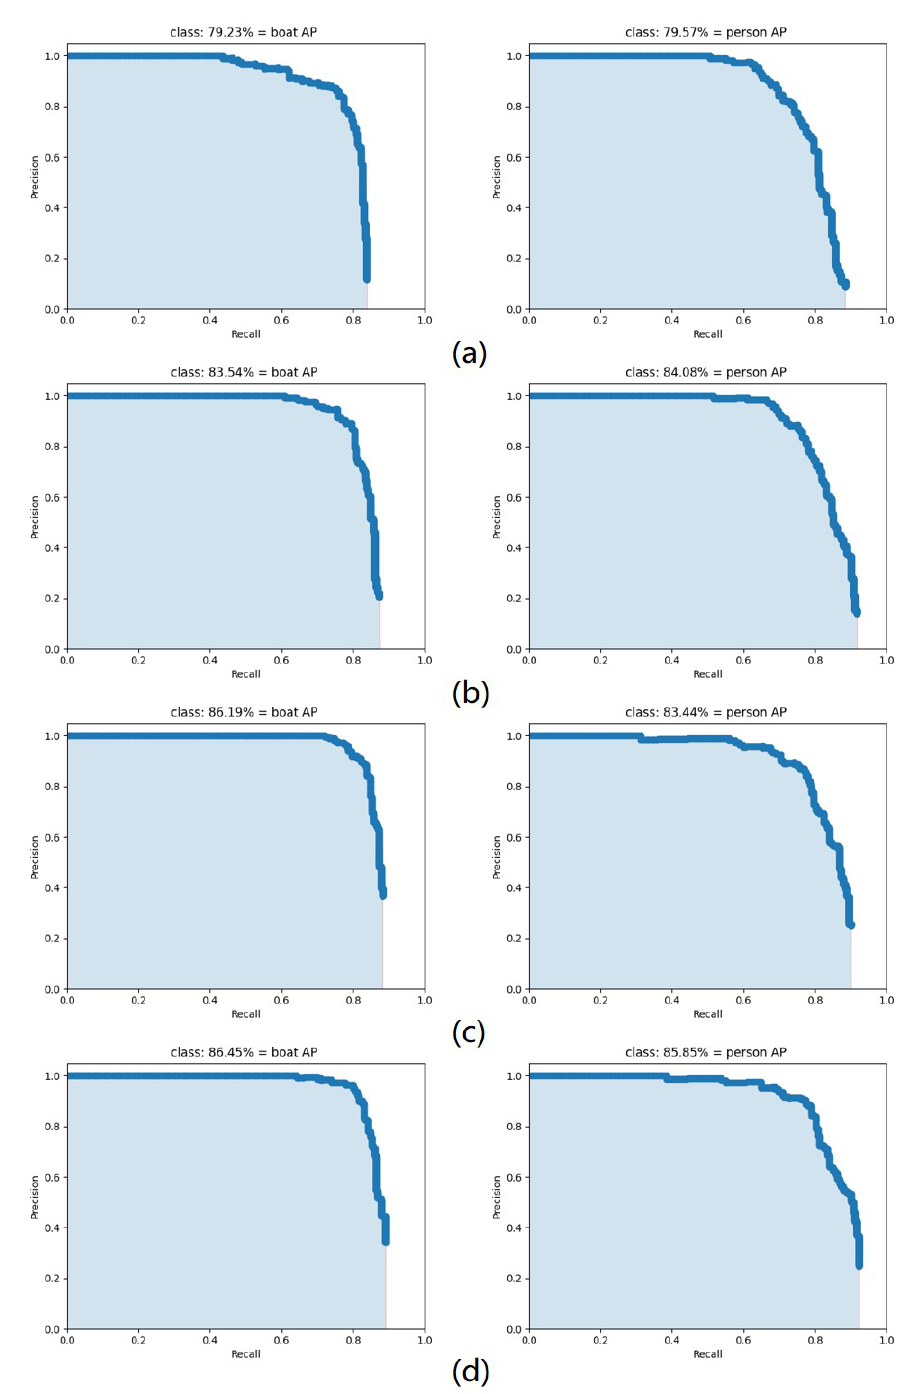
Figure 7. AP curves for the boat and person. ( a ) YOLOv4-tiny; ( b ) YOLOv4-tiny + SSR; ( c ) YOLOv4- tiny + SSR + RFB_sim; ( d ) YOLOv4-tiny + SSR + RFB_sim + CBAM